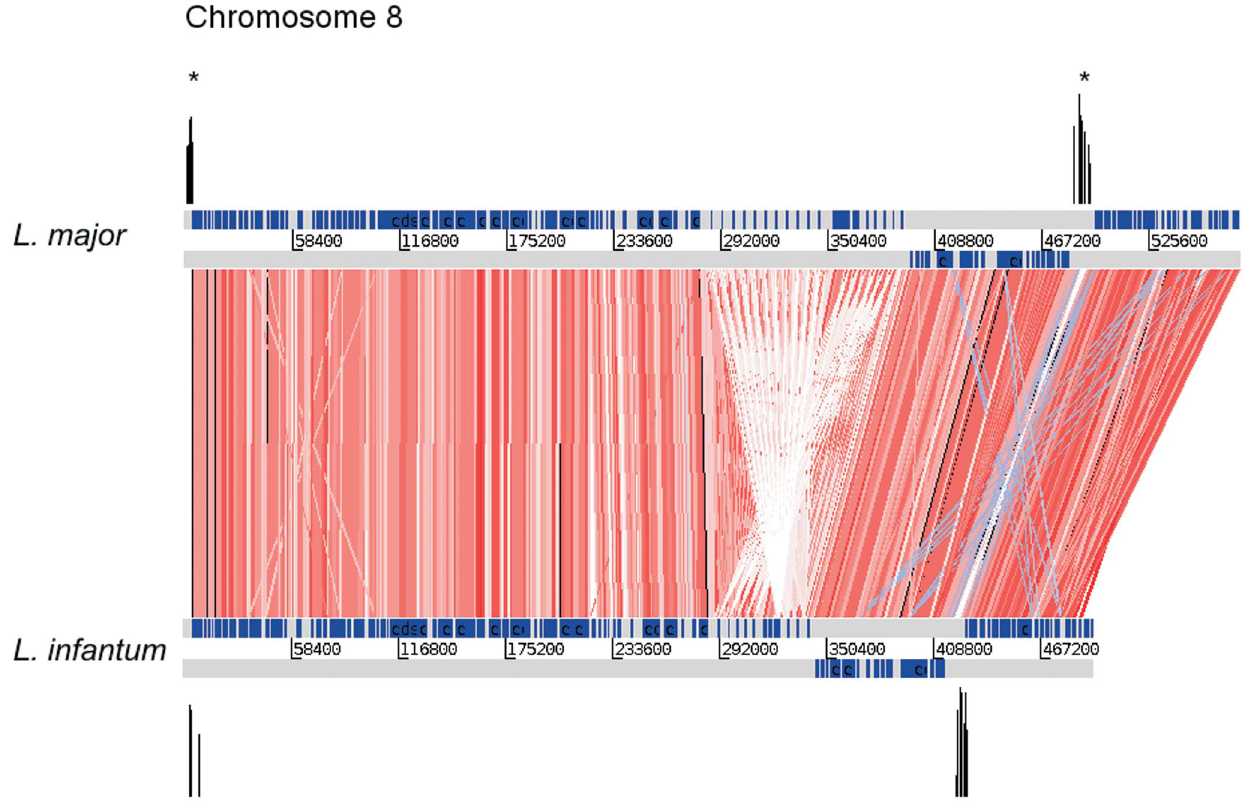
Figure 5. Location conservation of high RIIC scoring regions in L.major and L.infantum chromosome 8. The graphs are the same as figure 1. Blast HSPs longer than 100 bp and with at least 80% similarity are displayed in red scale and blue lines represent inversions.